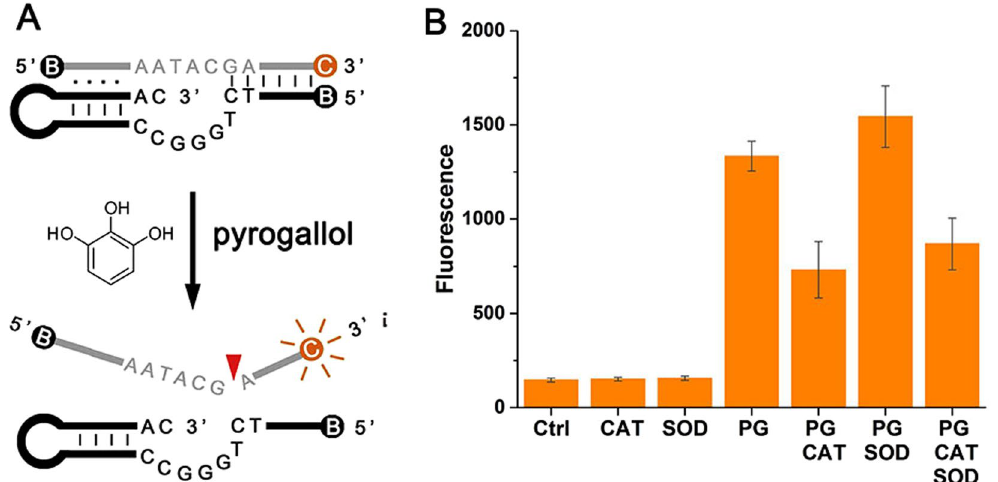
Figure 5. Effect of pyrogallol (PG) on a fluorescent labeled trans -PLDz. ( A ) Design of a fluorescent labeled trans -PLDz. C indicates Cy3, B indicates BHQ2. ( B ) Effects of CAT/SOD on the cleavage reaction of PLDz in the presence of PG. Reaction condition: 50 nM PL B , 50 nM S BC , 10 μ M PG (50 mU/ μ l CAT, 5 mU/ μ l SOD), 300 mM NaCl and 50 mM MES (pH 6.0) at 37 °C for 1